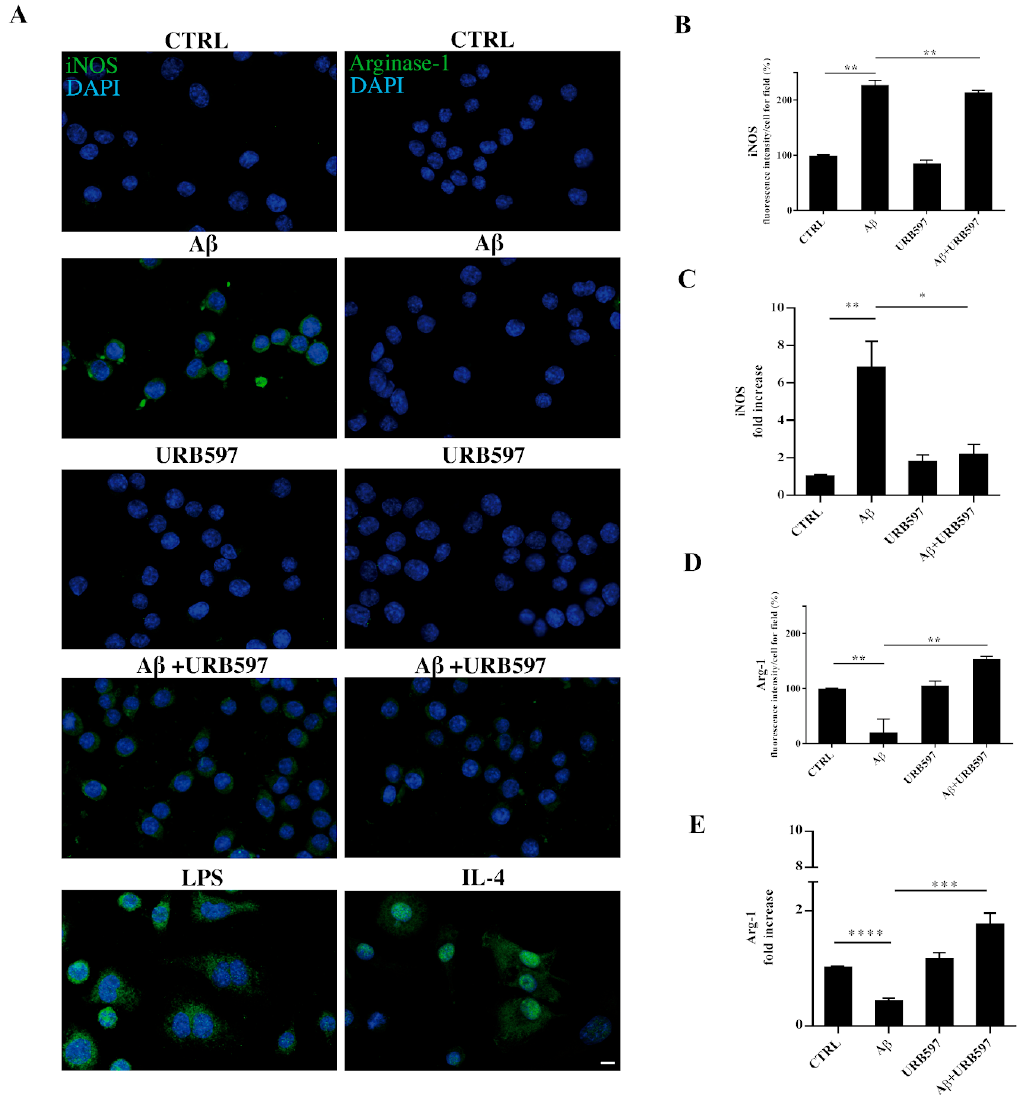
Figure 9. BV-2 cells were pre-treated with URB597 5 µ M for 4 h and incubated with A β 25–35 30 µ M for 24 h. LPS and IL-4 were used as positive controls for iNOS and Arg-1 markers, respectively. Representative immunofluorescence images of iNOS and Arg-1 ( A ). Quantitative immunofluorescence analysis of iNOS ( B ) and Arg-1 ( D ). Quantification of fluorescence signal intensity was analyzed using ImageJ software. The results are expressed as the mean ± SD of three independent experiments. ** p < 0.01 . Bar 20 µm. iNOS ( C ) and Arg-1 ( E ) mRNA expressions were evaluated by qRT-PCR at 24 h. Data are shown as mean ± SD from three independent experiments performed in triplicate. Expression profiles were determined using the 2 −ΔΔ CT method. * p < 0.05 , ** p < 0.01 . *** p < 0.001 , **** p < 0.0001 .